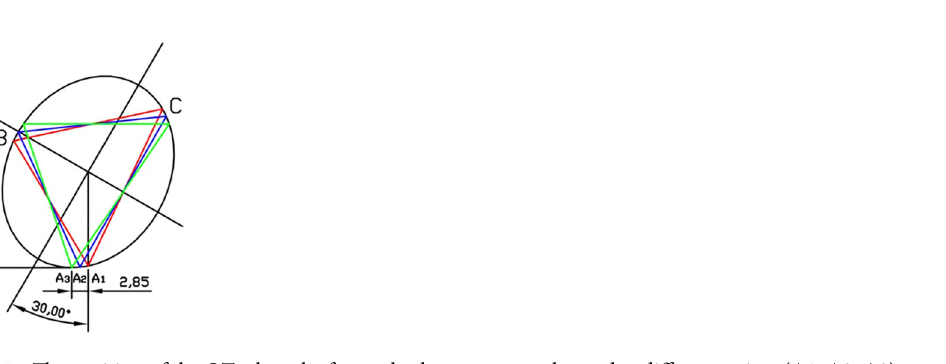
Figure 5. The position of the OT when the femoral calcar screw was located at different points (A1, A2, A3). The triangle with the femoral calcar screw at point A1 was red; the triangle with the femoral calcar screw at point A2 was blue, the triangle of the femoral calcar screw at point A3 was green.